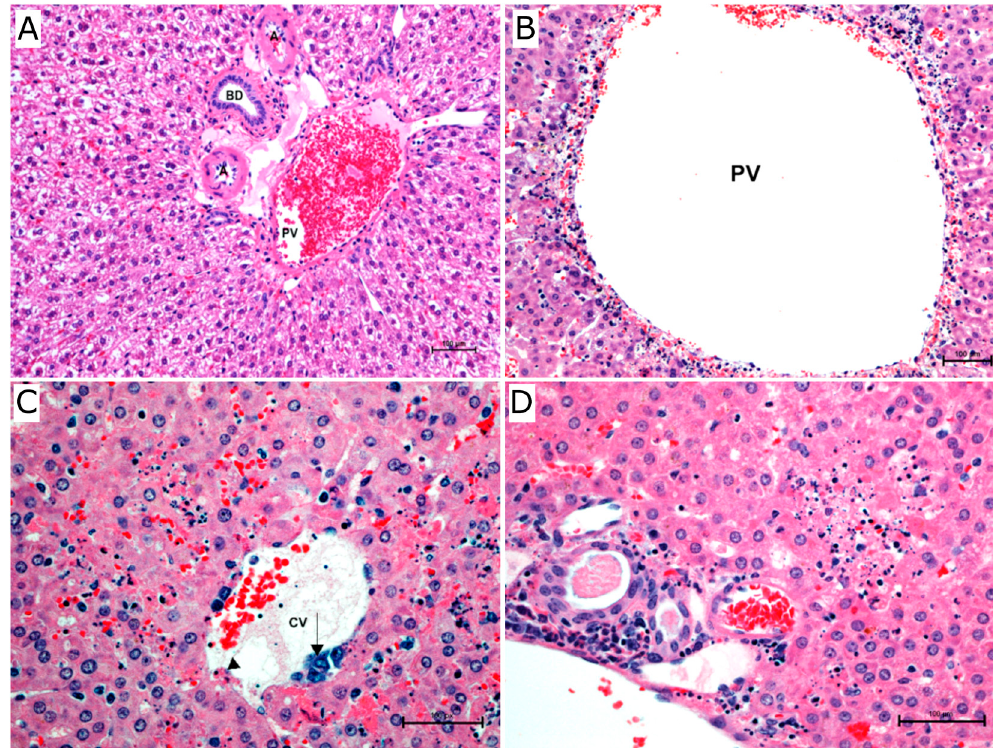
Figure 2. Histopathology of PIRV-infected hamsters. ( A ) Normal liver from a control hamster showing intact limiting plate (hepatocyte layer) surrounding portal triad that contains hepatic artery (A), portal vein (PV) and bile duct (BD). Histopathology of PIRV-infected hamsters 7 days post infection (PI). ( B ) Histologic changes in liver showing circumferential necrosis of the limiting plate with abundant karyorrhectic debris from dead hepatocytes immediately surrounding portal vein (PV) and necrosis and loss of lining endothelial cells (H and E staining, original magnification 100×). ( C ) Liver of infected hamster showing endothelial necrosis (arrowhead) where cells are replaced by eosinophilic cellular debris and pyknotic nuclei with focal intimal hyperplasia of central vein (CV) (arrow) (H and E stain, original magnification 200×). ( D ) Liver of infected hamaster showing random foci of lytic necrosis where hepatocellular details are lost with mixed inflammatory infiltrates expanding portal triads. Bars = 100 μ m.